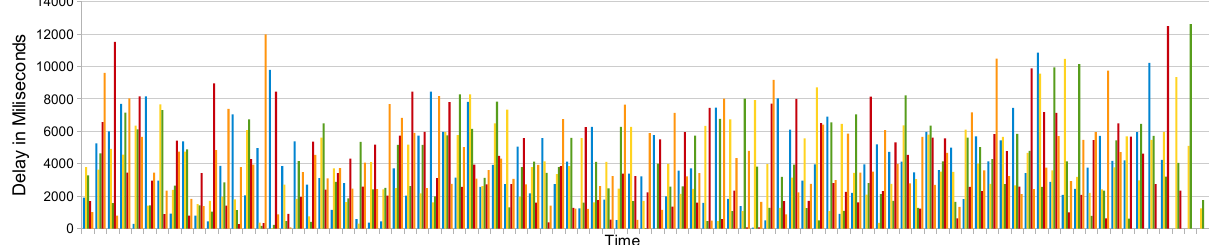
Figure 18. Variation of round-trip time (delay / latency) over a period of time where seven requests are being processed completed for a virtual sensors S as S i where i is the virtual sensor identifier. The x-axis in Fig. 17